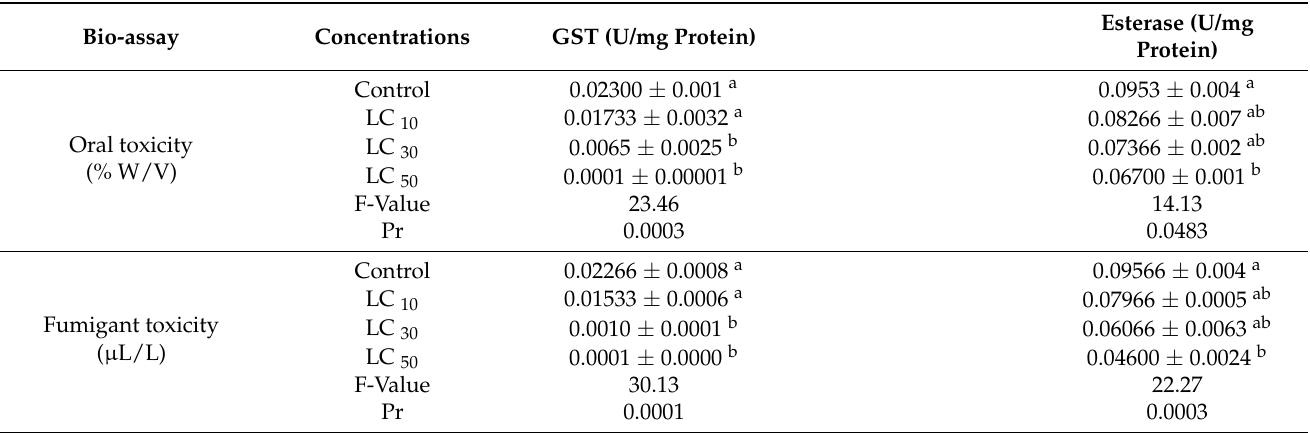
Table 5. Effect of the different concentrations of Artemisia annua flowers’ essential oil on the activity of glutathione S-transferase (GST) and esterase in 4th instar larvae of Glyphodes pyloalis .